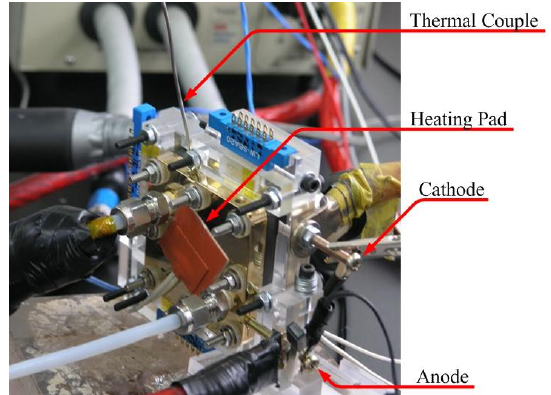
Figure 6. Fuel cell testing system.